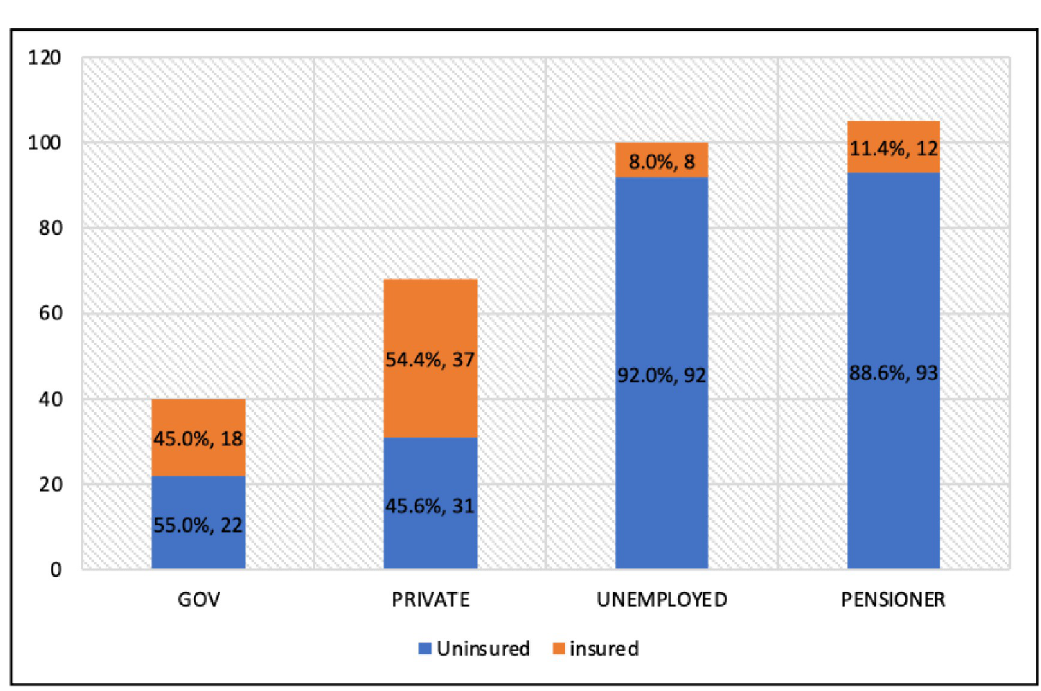
Fig 2. Distribution of participants’ occupation and association with health insurance status among T2DM patients at UKM teaching hospital.